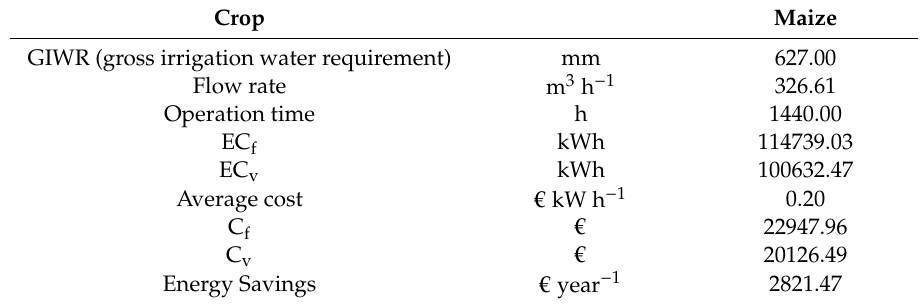
Table 2. The consumption and cost of energy for the pumping stations with fixed and variable speeds. Crop Maize GIWR (gross irrigation water